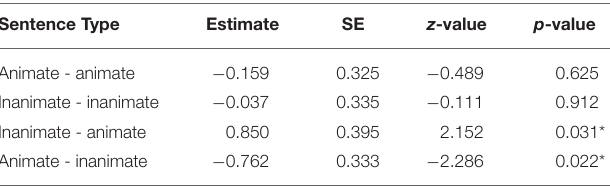
TABLE 5 | Adult verbal response results: Pairwise contrasts, comparing No Face, and Face conditions for each sentence type. Sentence